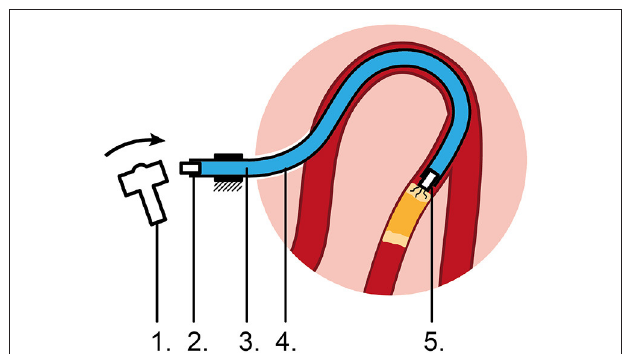
FIGURE 1 | Proposed flexible impulse hydraulic catheter. 1: Input mechanism, 2: Input piston, 3: Hydraulic medium, 4: Flexible catheter shaft, 5: Output piston impacting on the CTO, causing micro